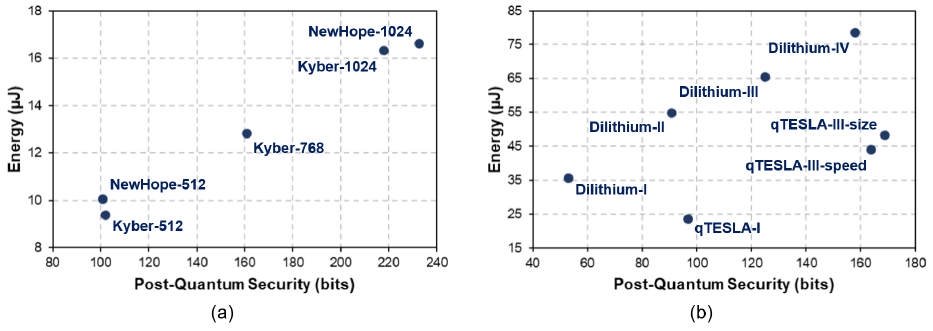
Figure 13: Energy consumption of Ring-LWE and Module-LWE-based (a) CCA-KEM- Encaps and (b) Sign algorithms at different post-quantum security